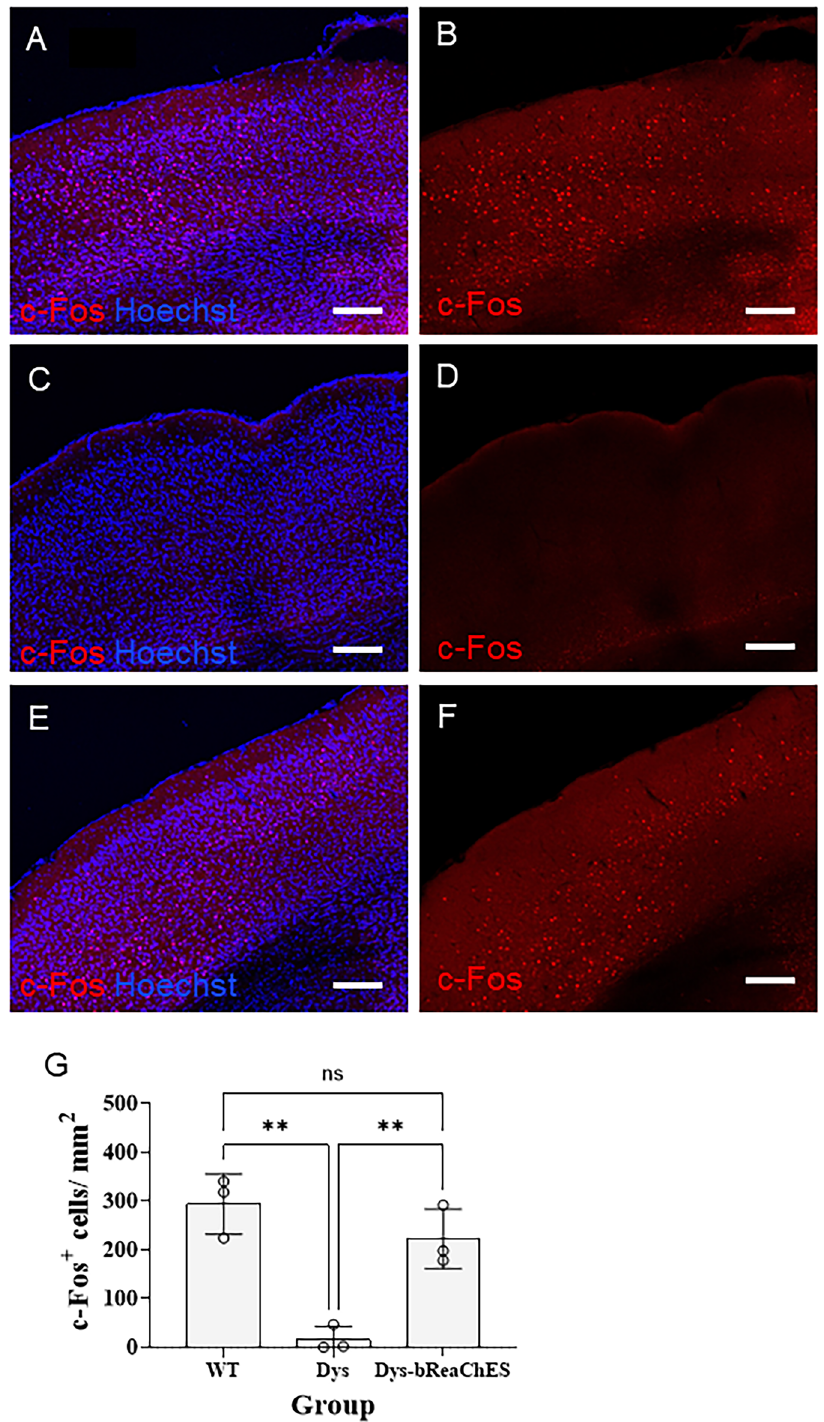
Figure 5. Neural activation of the visual cortex as measured by c-Fos expression following ocular light stimulation. c-Fos expression in untreated wild-type ( A , B ), untreated dystrophic ( C , D ) and bReaChES-treated dystrophic ( E , F ) mice. ( G ) Number of c-Fos-positive cells in the visual cortex demonstrating restoration of anatomical visual drive to the cortex in treated dystrophic mice (N = 3 mice per group). Abbreviation: WT = wild-type; Dys = dystrophic). Scale bar = 200um. Error bars indicate ± SD. * p < 0.05, one-way ANOVA with two-sided Dunnett’s